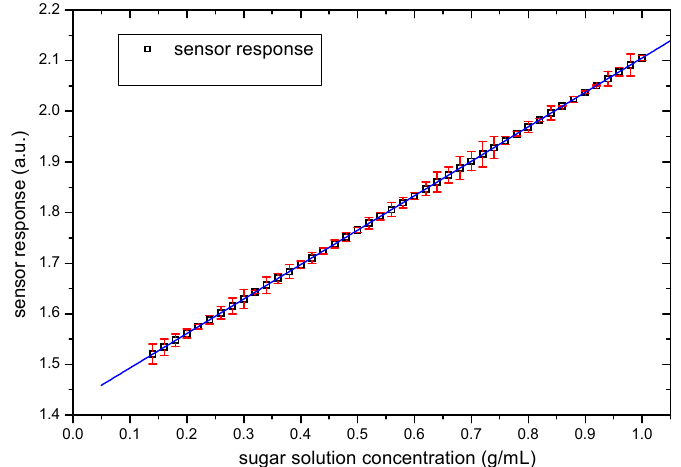
Figure 8. Sucrose sensor response. The squares represent the experimental data and the solid line the best fitting of a line to the experimental points.